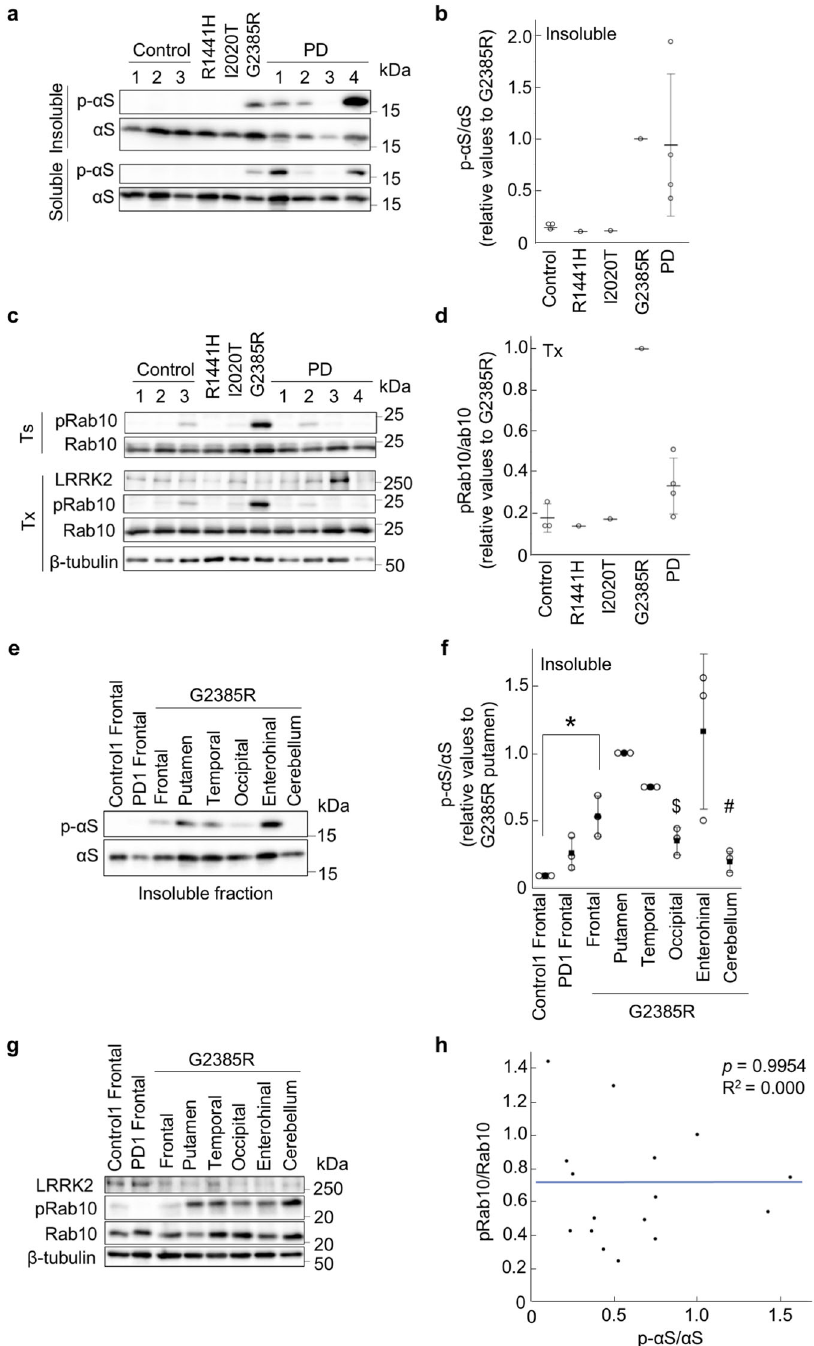
Fig. 2 Increased levels of phospho-Rab10 by LRRK2 G2385R is not associated with phospho- α S accumulation. a α S and phospho- α S (p- α S) in sarkosyl-soluble and insoluble fractions of brain autopsies. b Graph representing quanti fi cation of sarkosyl-insoluble p- α S normalized with sarkosyl-insoluble α S as shown in a . Dots represent average from three technical replications. Horizontal lines and error bars indicate average and standard deviation, respectively. c Phospho-Rab10 (pRab10) in Tris buffer (Ts) and Triton X-100 (Tx)-soluble fractions. ß-tubulin serves as a loading control. d Graph representing quanti fi cation of pRab10 in Triton X-100 (Tx)-soluble fraction as shown in c . Dots represent average from three technical replications. Horizontal lines and error bars indicate average and standard deviation, respectively. e Sarkosyl-insoluble α S and p- α S levels in different brain regions of the LRRK2 G2385R case. Extracts of the frontal lobes in control-1 and PD-1 served as controls. f Graph represents quanti fi cation of sarkosyl-insoluble p- α S normalized with sarkosyl-insoluble α S as shown in e . *p < 0.0001 vs . control-1 frontal by Dunnett ’ s test. # p = 0.0075; $ p = 0.0293 vs . G2385R putamen by Dunnett ’ s test. n = 3 technical replications. g Tx-soluble LRRK2, Rab10, and pRab10 levels in different brain regions of the LRRK2 G2385R case. h Correlation analysis between the levels of sarkosyl-insoluble p- α S normalized with α S and those of Tx-soluble pRab10 normalized with Rab10 in the LRRK2 G2385R case. P- value and coef fi cient of determination are calculated using Pearson ’ s test with the data in e and g . The blue line represents linear regression